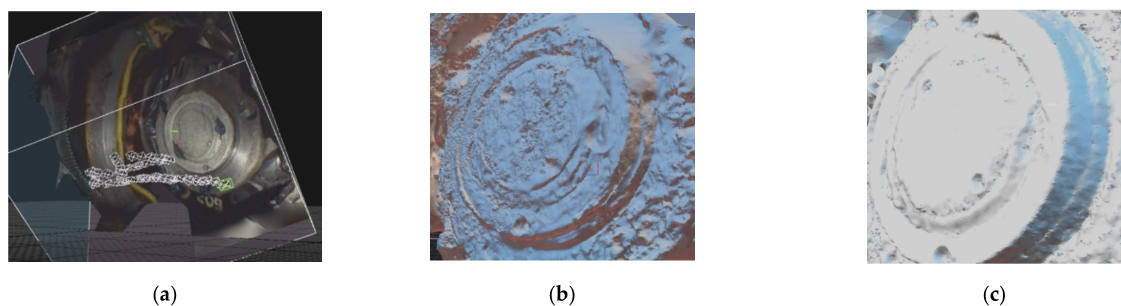
Figure 23. An endoscopy 3D mesh aligned with RealityCapture: ( a ) alignment; ( b ) meshed point cloud; and ( c ) meshed point cloud by